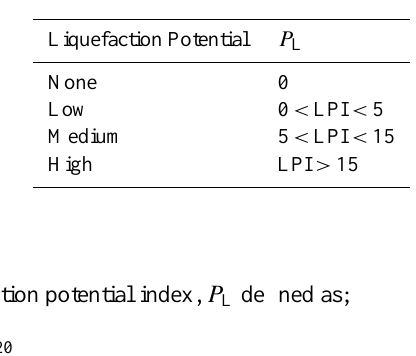
Figure 13. Comparison of Regional Damage Map of the 1894 Earthquake (Lav, Fig. 13. Comparison of Regional Damage Map of the 1894 earth- 1994) and Liquefaction Susceptibility microzonation map prepared for the quake (Lav, 1994) and Liquefaction Susceptibility microzonation probability of exceedance of 10% in 50 years ( İ nce, 2005). map prepared for the probability of exceedance of 10% in 50yr (˙Ince, 2005).